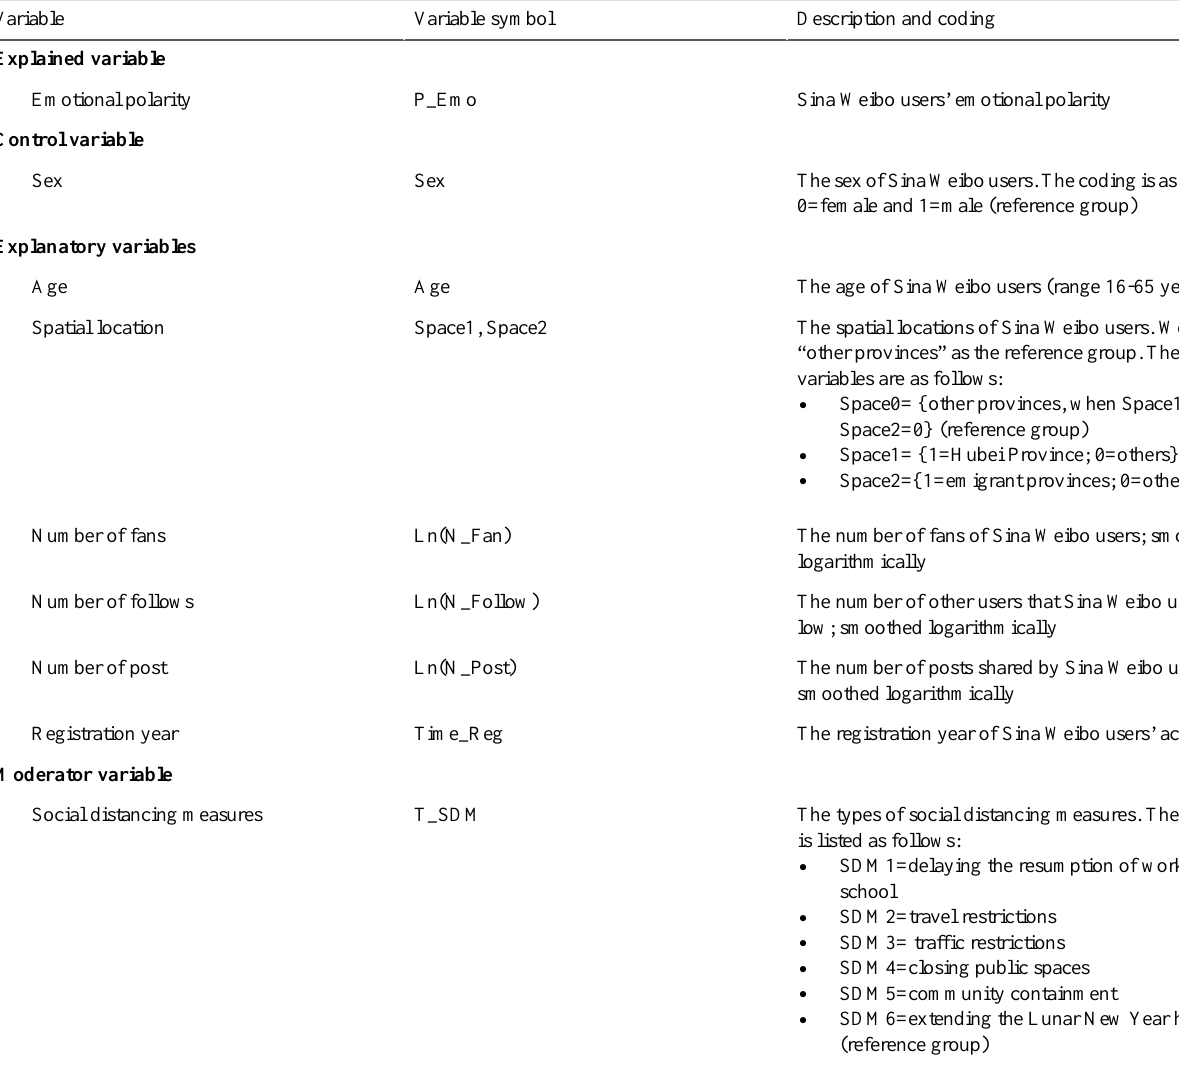
Description and codingVariable